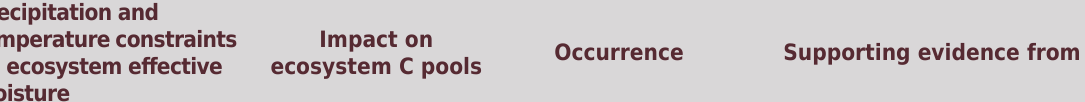
Table 2. Major climate constraints (temperature and precipitation) on ecosystem effective moisture (EEM) and their impacts on ecosystem C pools (vegetation and soils) across the major Brazilian biomes and supporting evidence from the literature